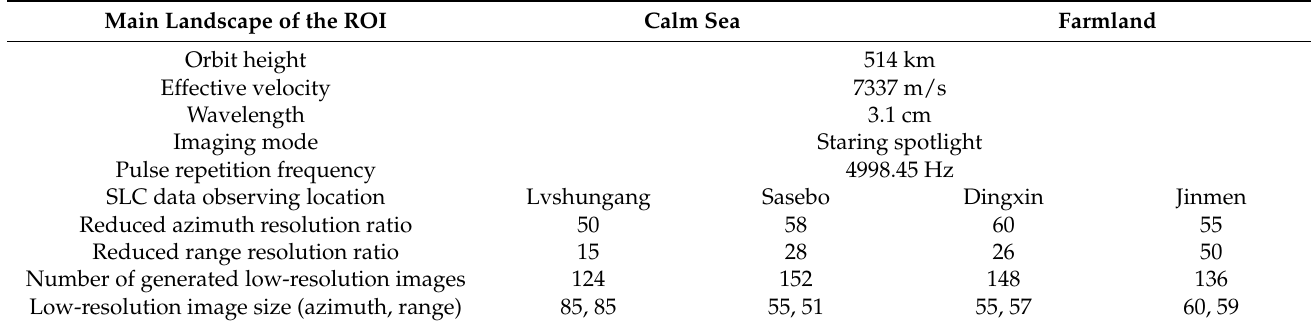
Figure 3. Segmentations of TerraSAR-X SLC data: ( a ) Lvshungang. ( b ) Sasebo. ( c ) Dingxin. ( d ) Jinmen. Their appearances are stretched and compressed in terms of the shapes and quantized amplitude for appropriate depiction. Table 1. Satellite platform/antenna and resolution variation